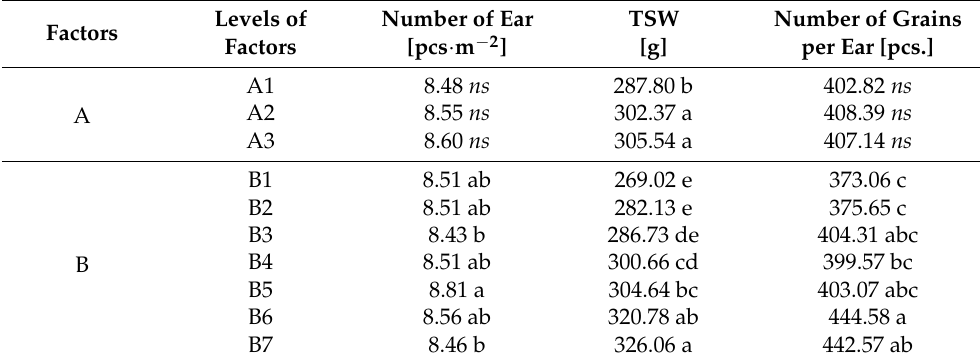
Table 1. Average values of grain yield components for cultivars (A) and fertilizer